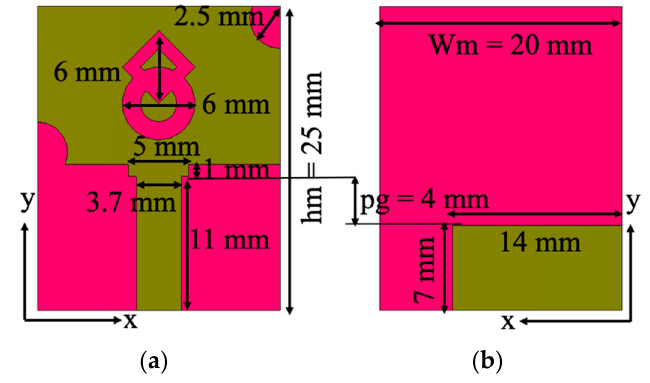
Figure 1. Antenna design: ( a ) front side, ( b ) back side.